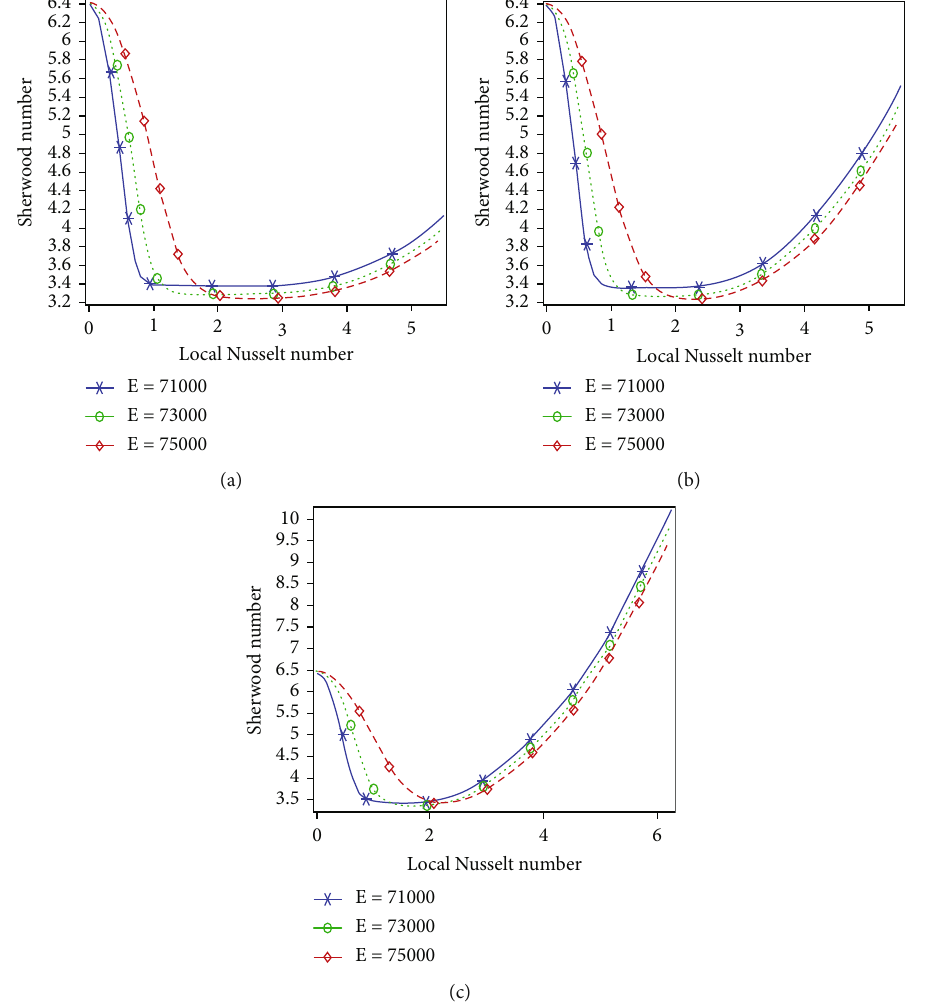
Figure 17: Sherwood number vs. the local Nusselt number at upstream along the backward step channel against the axial direction at (a) Re = 100 , I : C = 3 % , a = 0 : 5 ; (b) Re = 100 , I : C = 3 % , a = 0 : 6 ; and (c) Re = 100 , I : C = 3 % , a = 0 : 7